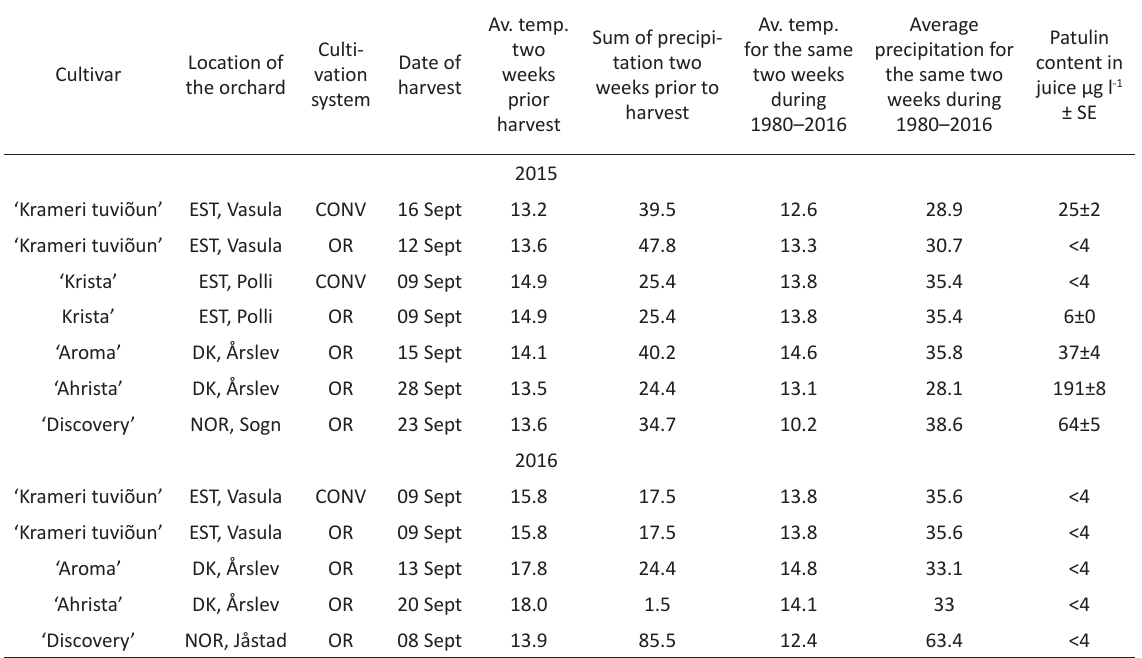
Table 3. Patulin content in juice pressed from Estonian, Danish and Norwegian apples in 2015 and 2016 in relation to average temperature (°C) and sum of precipitation (mm) during the two weeks prior harvest, and compared to the 36 year-average (1980– 2016) for the same